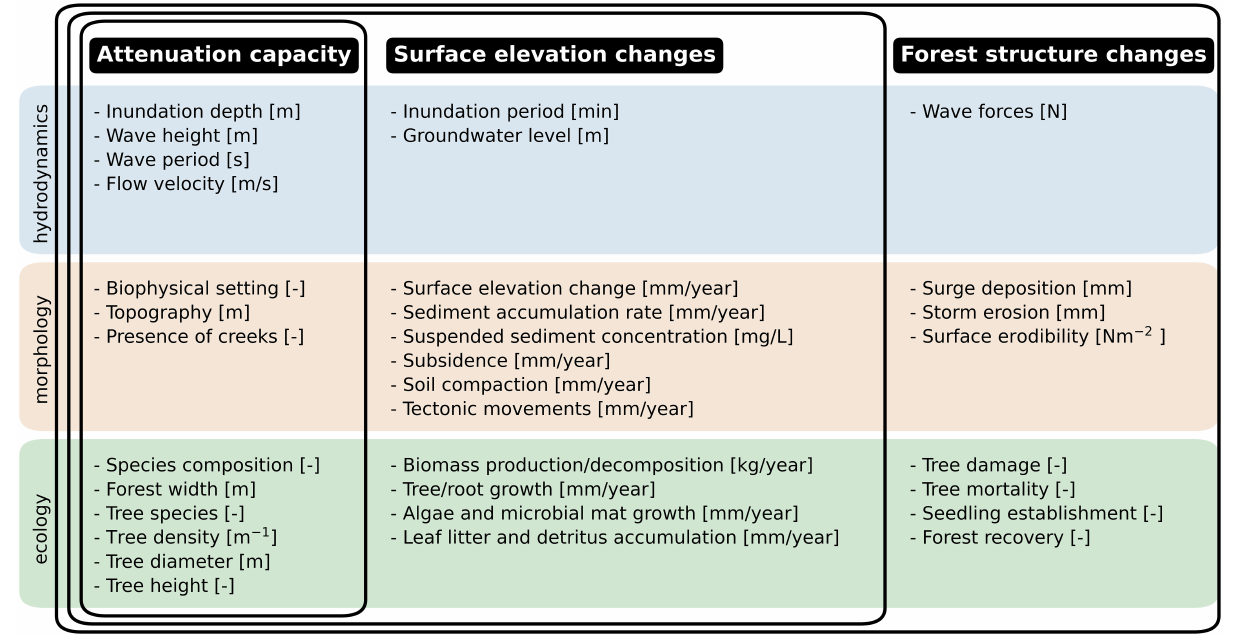
such as for infragravity waves. As a result, the functionality be